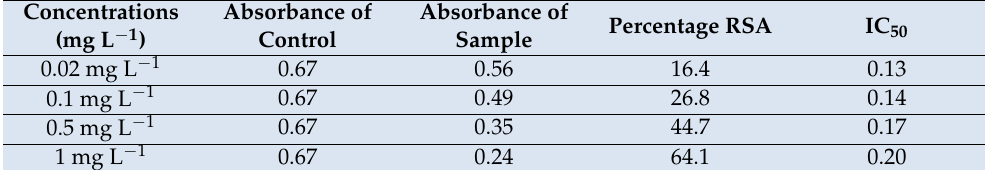
Table 2. Percentage Scavenging and IC 50 value of CuO.